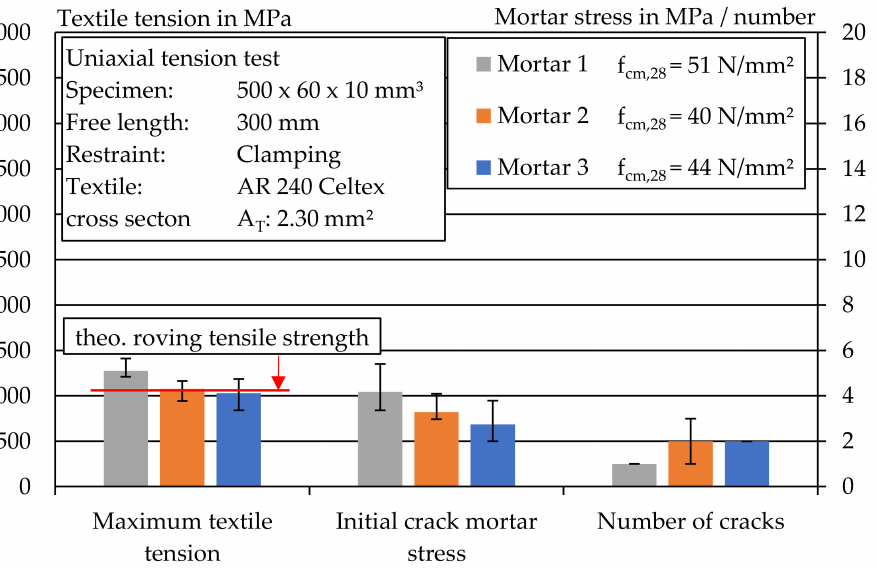
Figure 18. Overview of textile stress, initial mortar stress and number of cracks during uniaxial tension test of glass textile reinforced